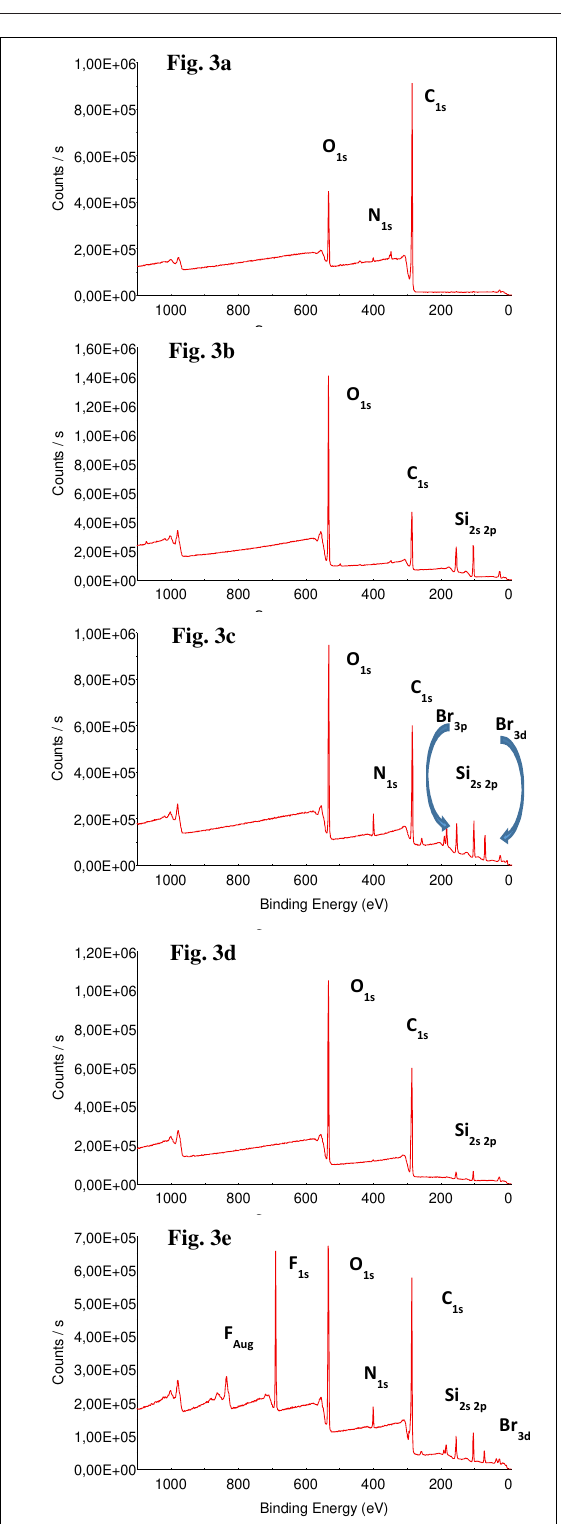
Fig. 3: XPS survey spectra of (a) bare PEN substrate, (b) silica IJP area, (c) silica functionalized with the silane bearing the ARTP initiator, polymer brushes using (d) HEMA or (e) PFPMA monomer. The surface elemental compositions as determined by XPS of the PEN substrate after each step of functionalization are reported in Table